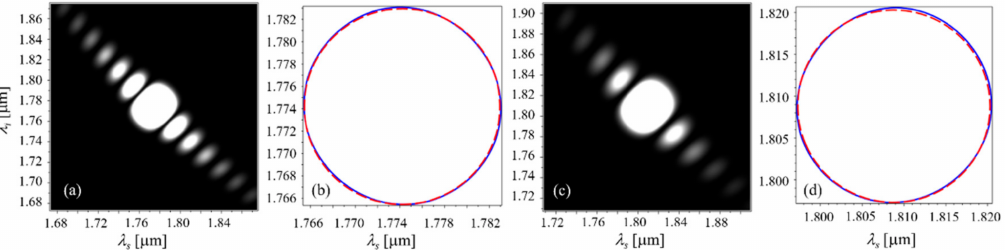
Figure 7. Type II case (3) in Table 1: ( a ) JSI, ( b ) the contour line for JSI = 0.5 (solid line) and a circle with a diameter of 17.5 nm (dashed line); Type II case (4) in Table 1: ( c ) JSI, ( d ) the contour line for JSI = 0.5 (solid line) and a circle with a diameter of 23 nm (dashed line). The calculated purity is 0.997 for both